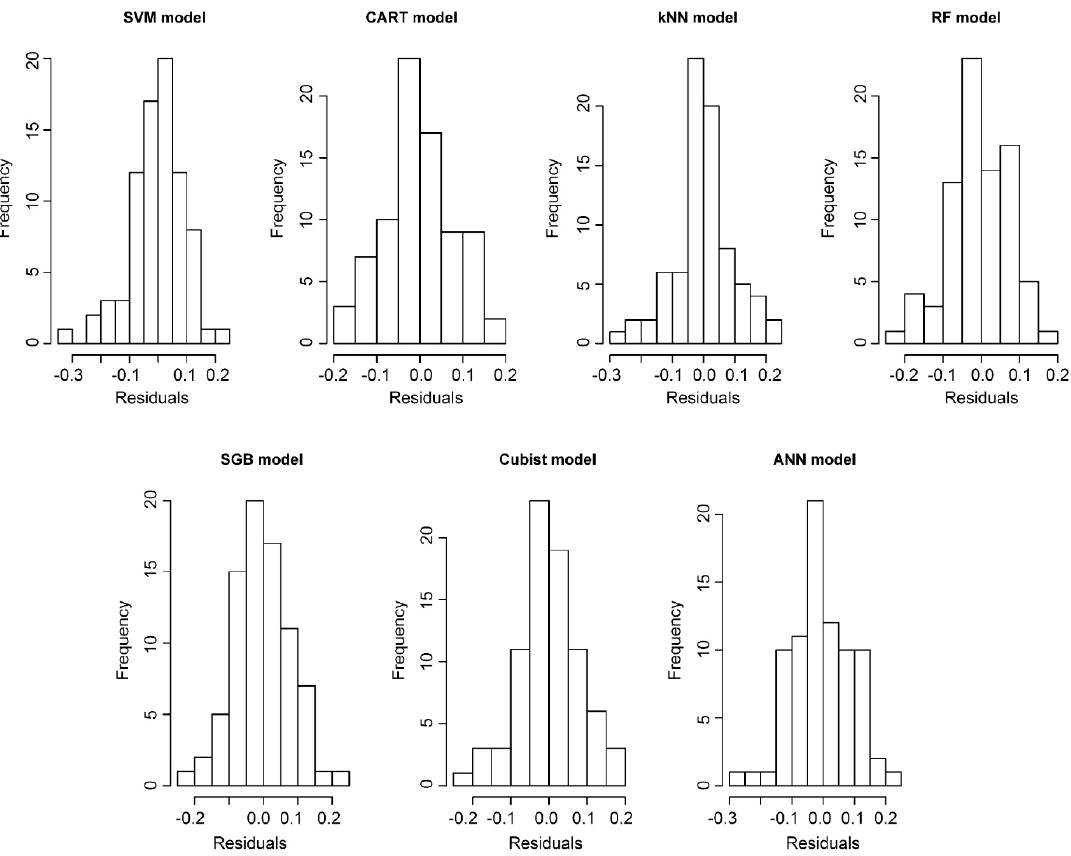
Figure 14. Histogram plots of the residuals of the models.